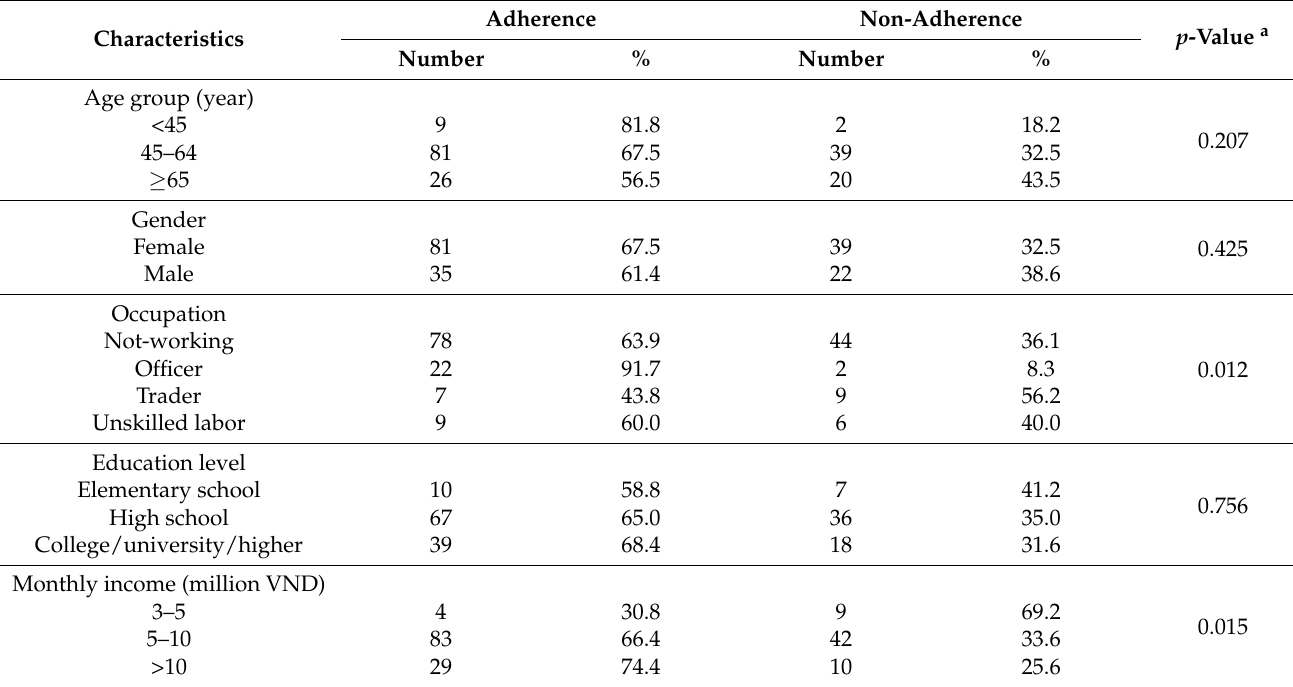
Table 4. The relationship between medication adherence and patients’ characteristics (two levels of adherence).